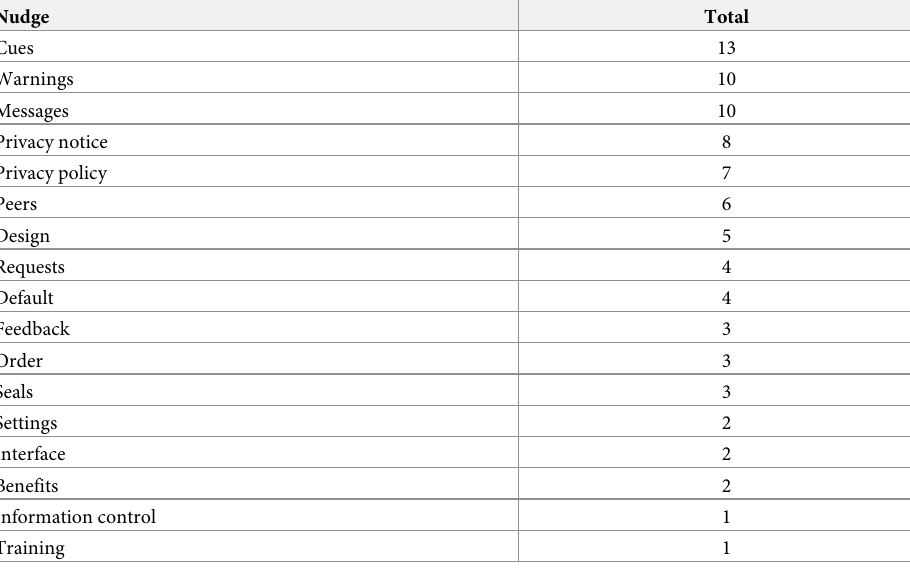
Table 4. Nudges in 54 papers included in the